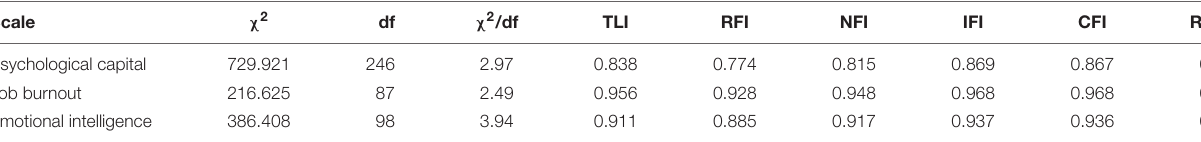
TABLE 2 | Confirmatory factor analysis results of the scale ( n =